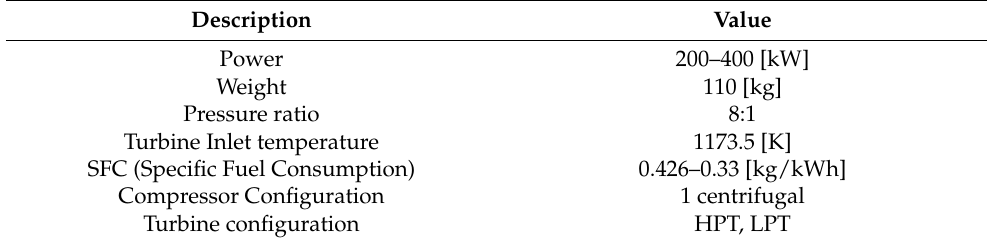
Table 1. PW200 technical specifications.